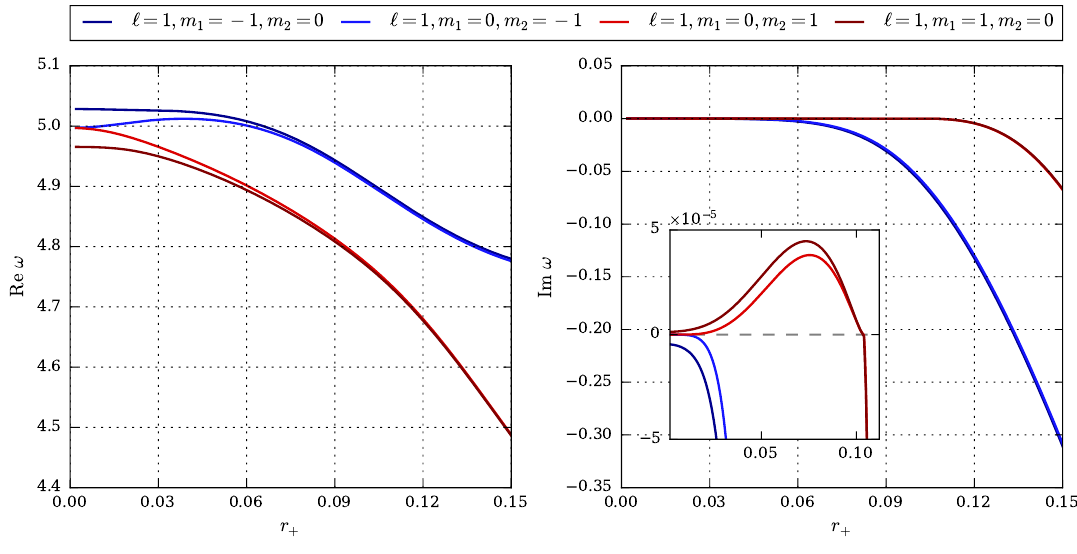
Figure 4 . The ‘ = 1 modes for a 12 = a 2 temperature T + ∼ 10 − 8 . The modes m 1 = 1 , m 2 = 0 (dark red) and m 1 = 0 , m 2 = 1 (light red) display a small positive imaginary part for values where = θ + < 0